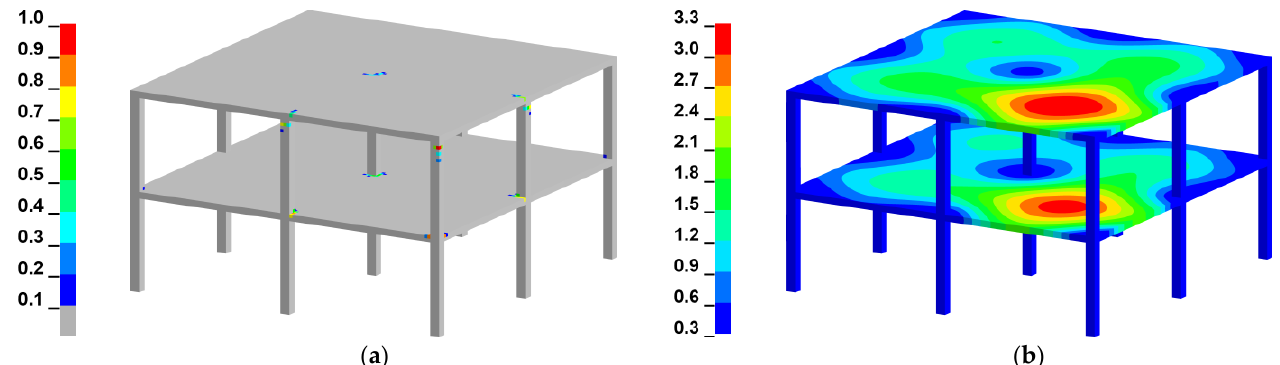
Figure 10. The state of equilibrium before corner column removal: ( a ) — damage; ( b ) — vertical displacements, mm.